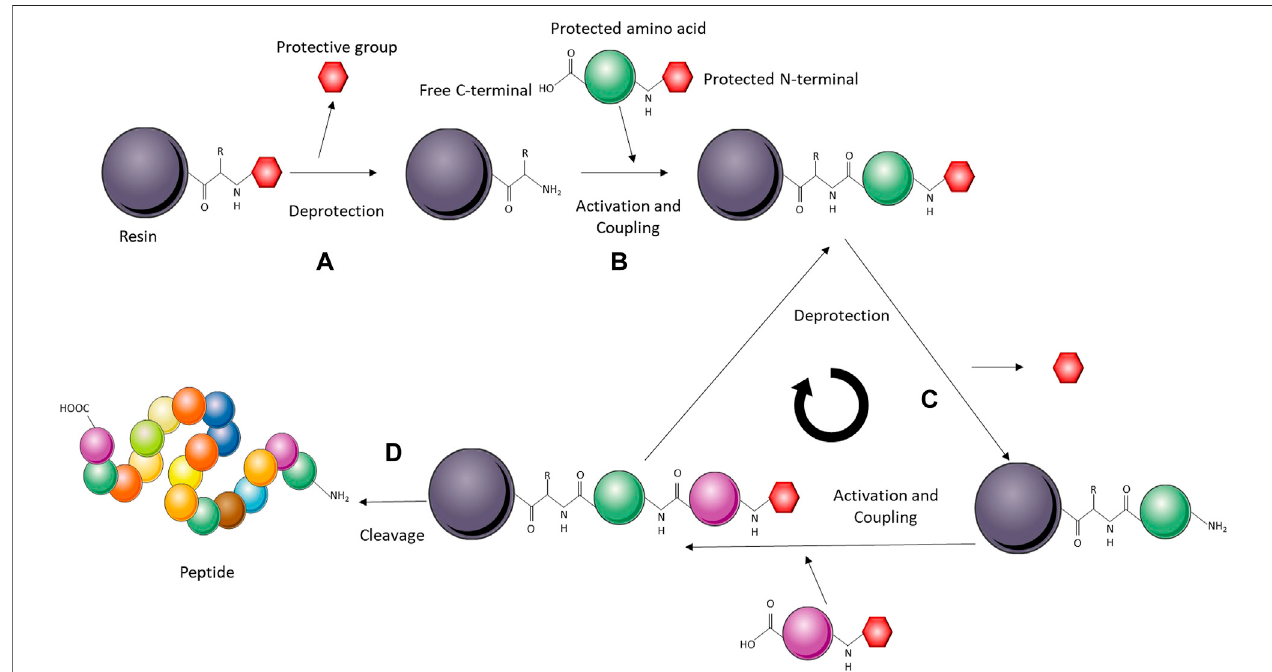
FIGURE 9 | Schematic representation of a solid-phase peptide synthesis (SPPS) system. The solid-phase (resin) is activated for peptide synthesis upon deprotection of the reactive amino group (A) . The amino acids are added sequentially on the C-terminal, while remaining protected on the N-terminal. The incoming aminoacidformsapeptidebondwiththefreeN-terminalontheresin (B) .Deprotectionoftheaminoacidlinkedtotheresinleavesafreeaminogroupreadytoreactwith thenext N-protected aminoacid (C) .Thecycle isrepeateduntil alltheaminoacidsareincorporated, uponwhichthepeptideiscleaved from theresinand refolded in vitro (D)